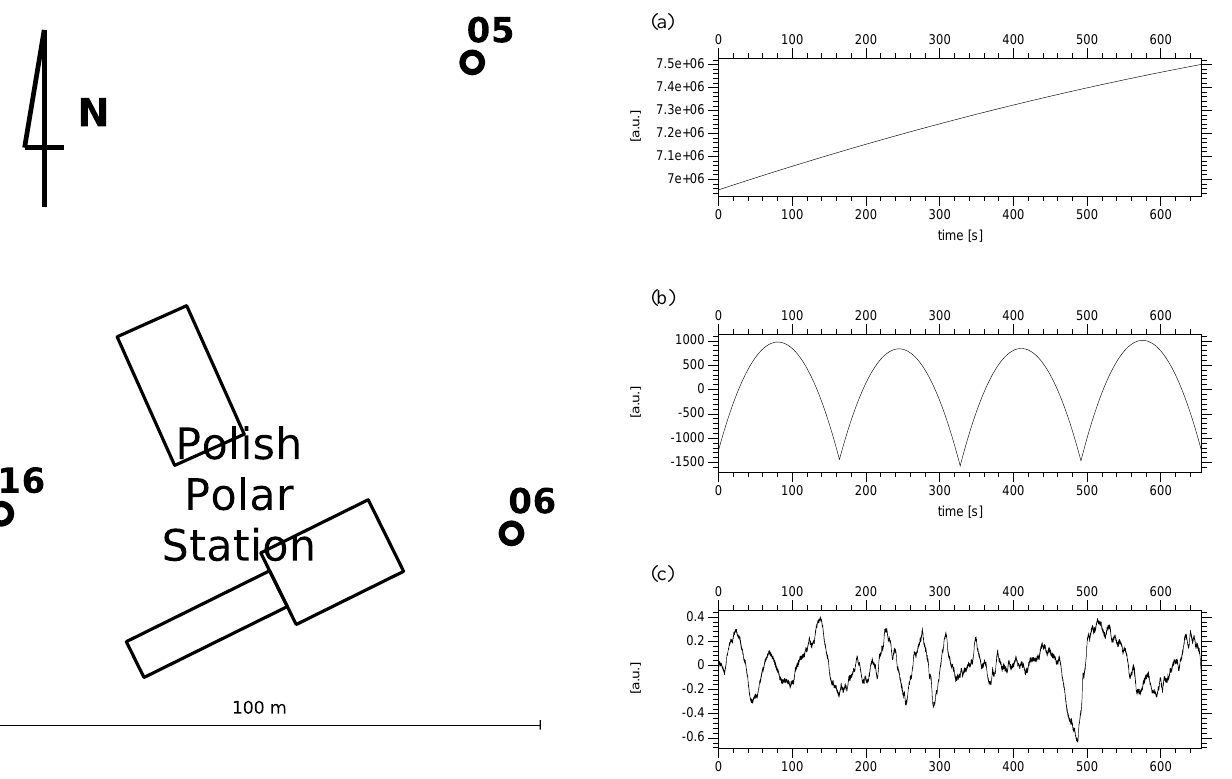
Fig. 1. Sketch of antennas position and orientation around Polish Polar Station.